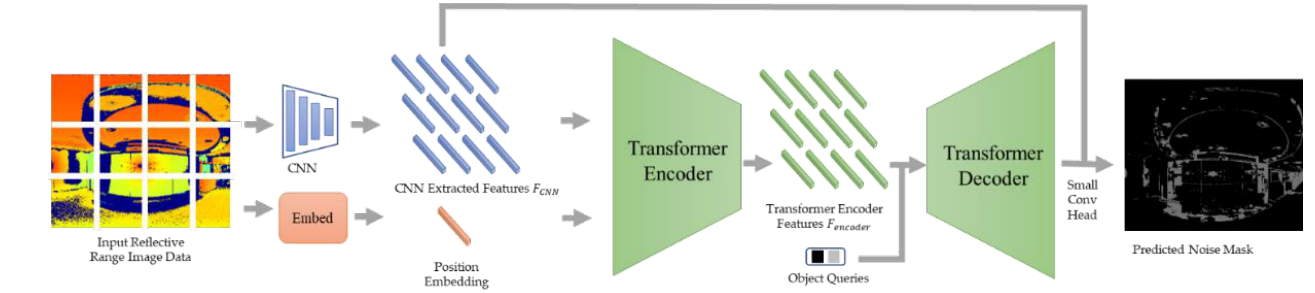
Figure 5. Range image-based noise detection module view.